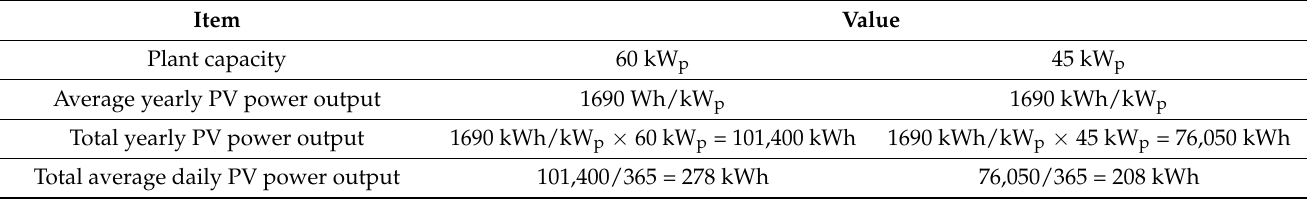
Table A4. Annual/Daily PV power output Mpantan MG–modelling